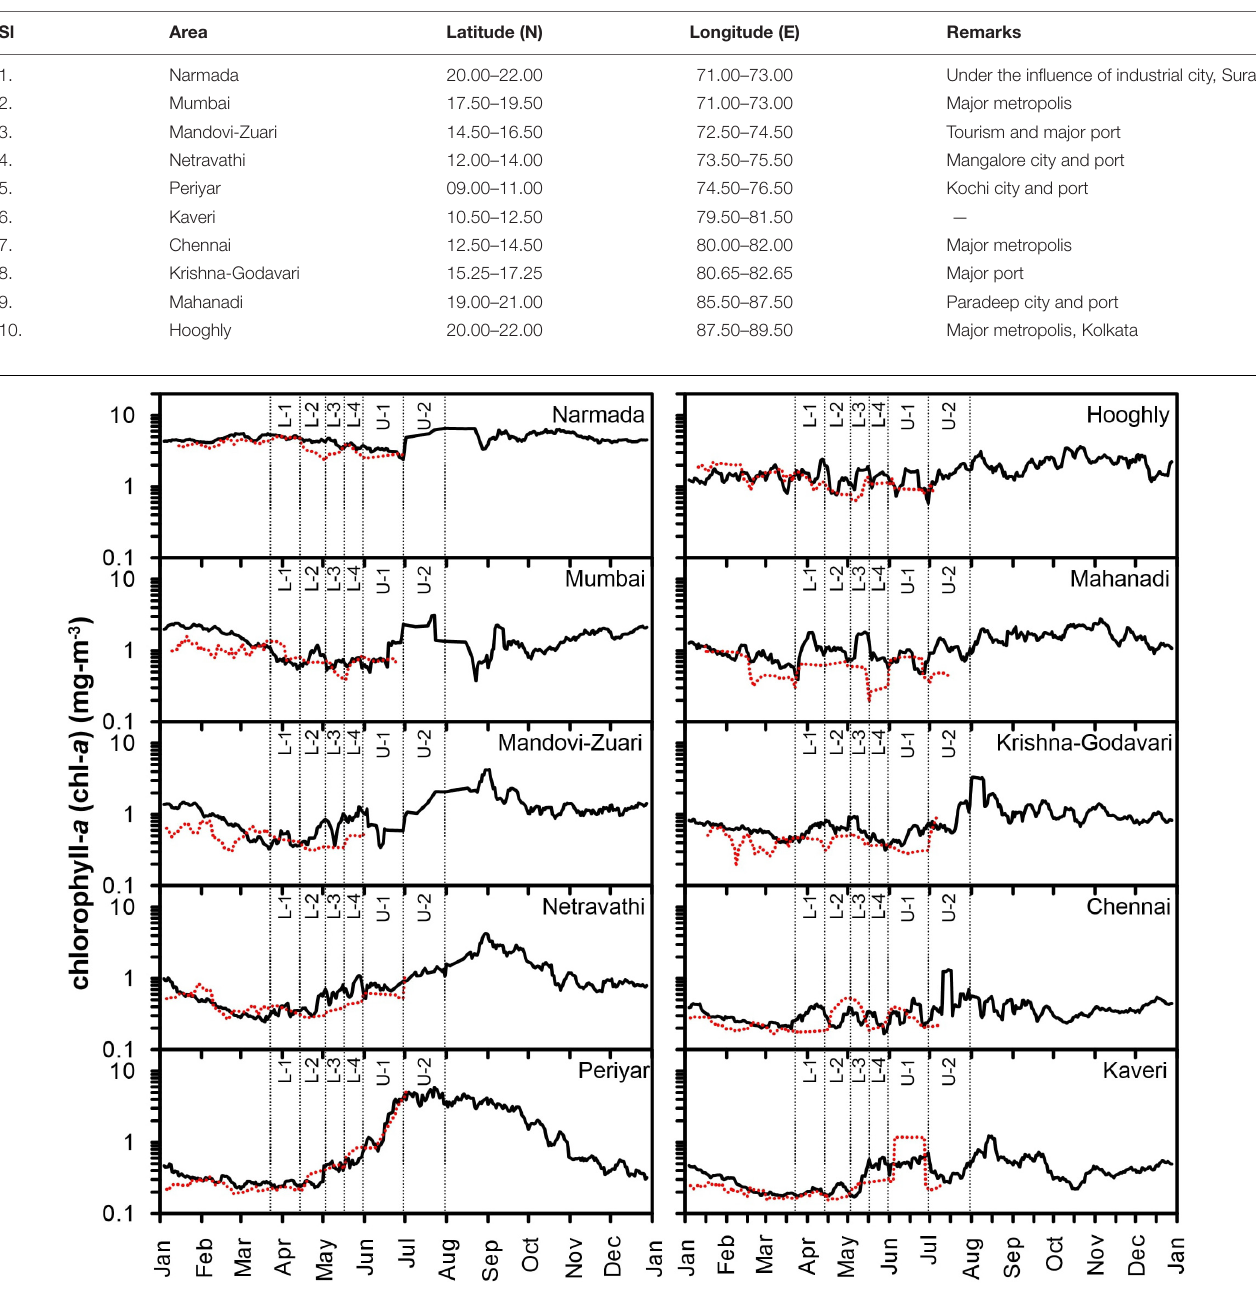
FIGURE 3 | Mean time-series variability in chl- a climatology (solid black line) and for the year 2020 (dotted red line) off major Indian cities and river basins.